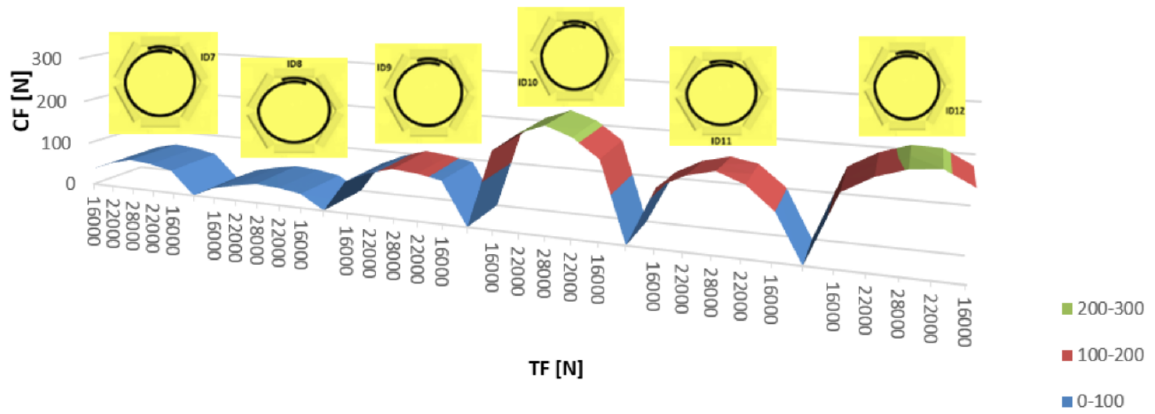
Figure 9: The course of CF for hexagonal idler housing